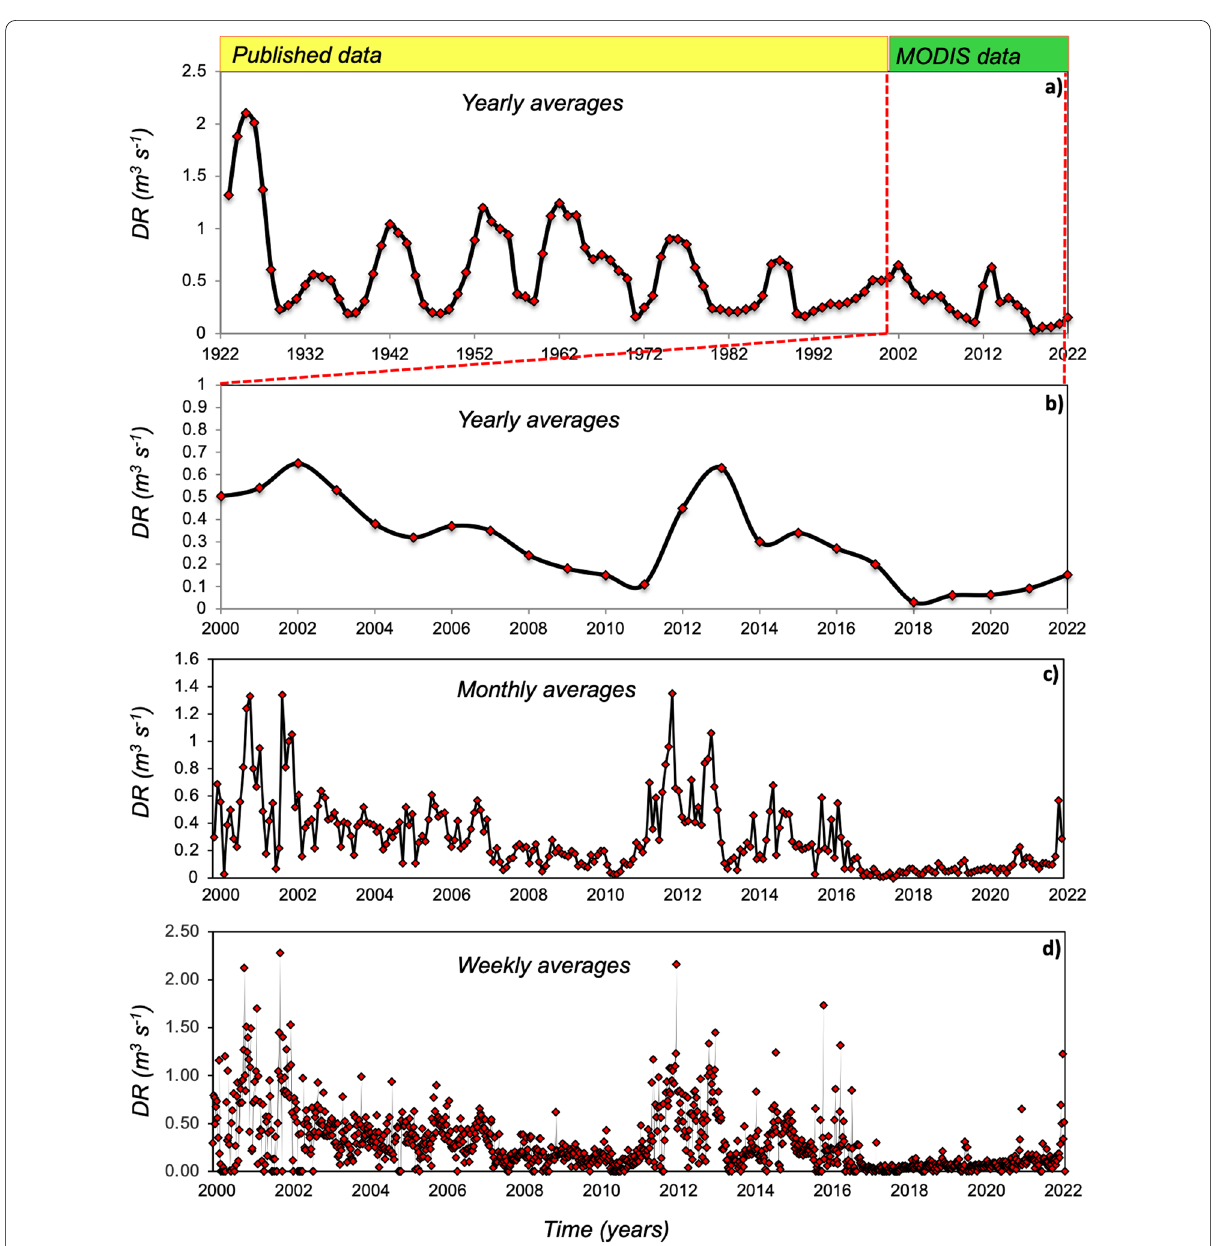
Fig. 2 a Averaged yearly discharge rates from 1922 to 2021 obtained combining literature data (Harris et al. 2003; Melnik et al. 2008; Scott et al. 2012; Drust, 2018; Rhodes et al. 2018; Zorn et al. 2020) and MODIS data (Coppola et al. 2016); b-c-d averaged yearly, monthly, and weekly discharge rates from 2000 to 2021 considering only MODIS